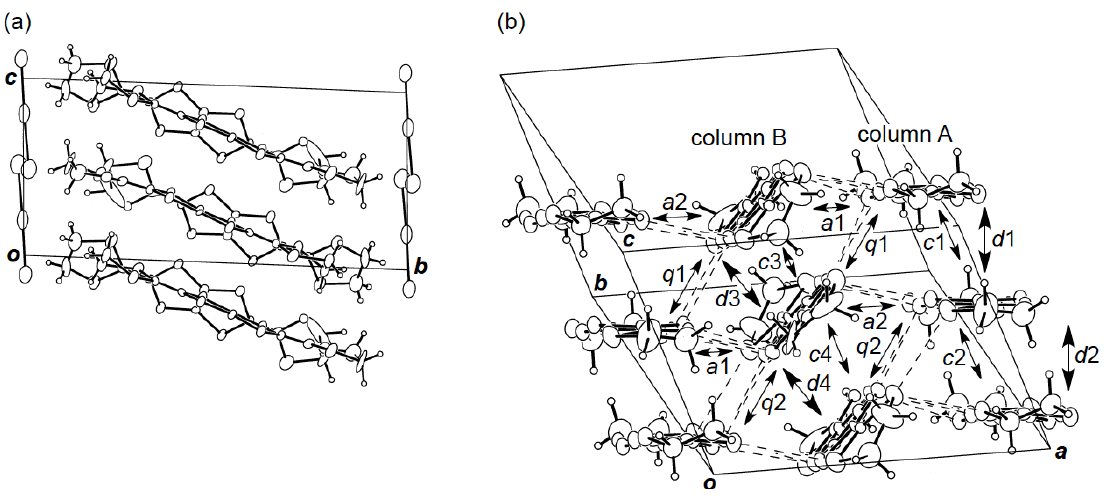
Figure 16. ( a ) Crystal structure of α-(DHOT-TTP) ( b ) Donor arrangement in α-(DHOT-TTP) and B are 3.66 ( d 1), 3.61 ( d 2), 3.57 ( d 3) and 3.66 ( d 4) Å, respectively. Short S···S contacts (< 3.70 Å) are drawn by broken lines. Intermolecular overlap integrals c 1, c 2, c 3, c 4, a 1, a 2, q 1 and q 2 are −2.72, −1.86, −2.96, −0.26, −5.61, −7.56, 6.10 and 9.07 × 10 −3 , respectively